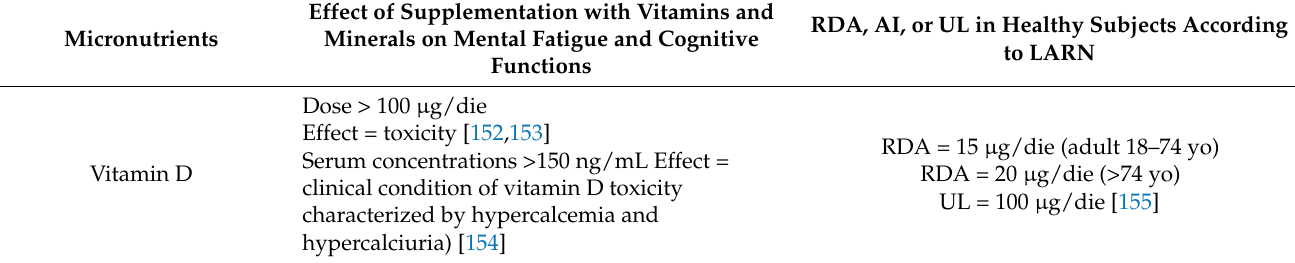
Table 2. Suggestions of micronutrients to include in the protocol, amounts that have shown effects on fatigue and cognitive function and recommended intake and tolerance levels for a healthy population.